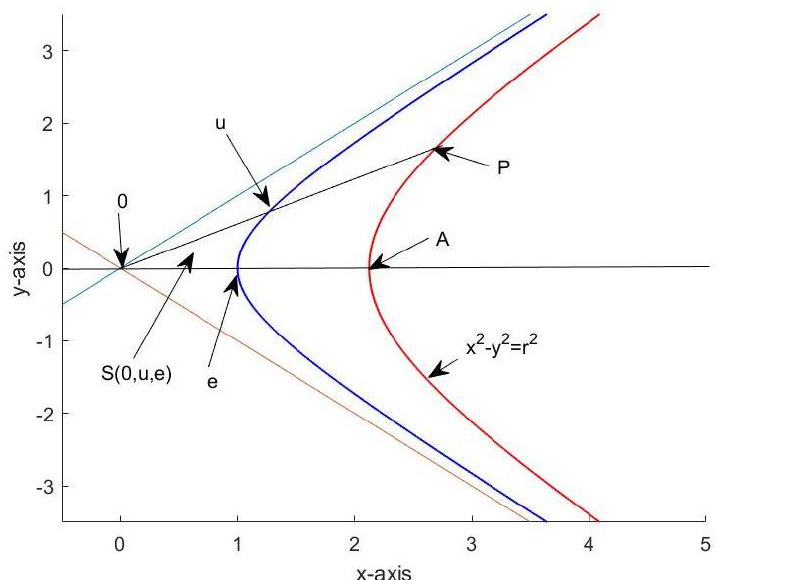
Figure 3. ψ equals two times the signed area content of the hyperbolic sector S ( o , u , e ) with u = z and where z = ( x , y ) T = Hyp X ( r , ψ )